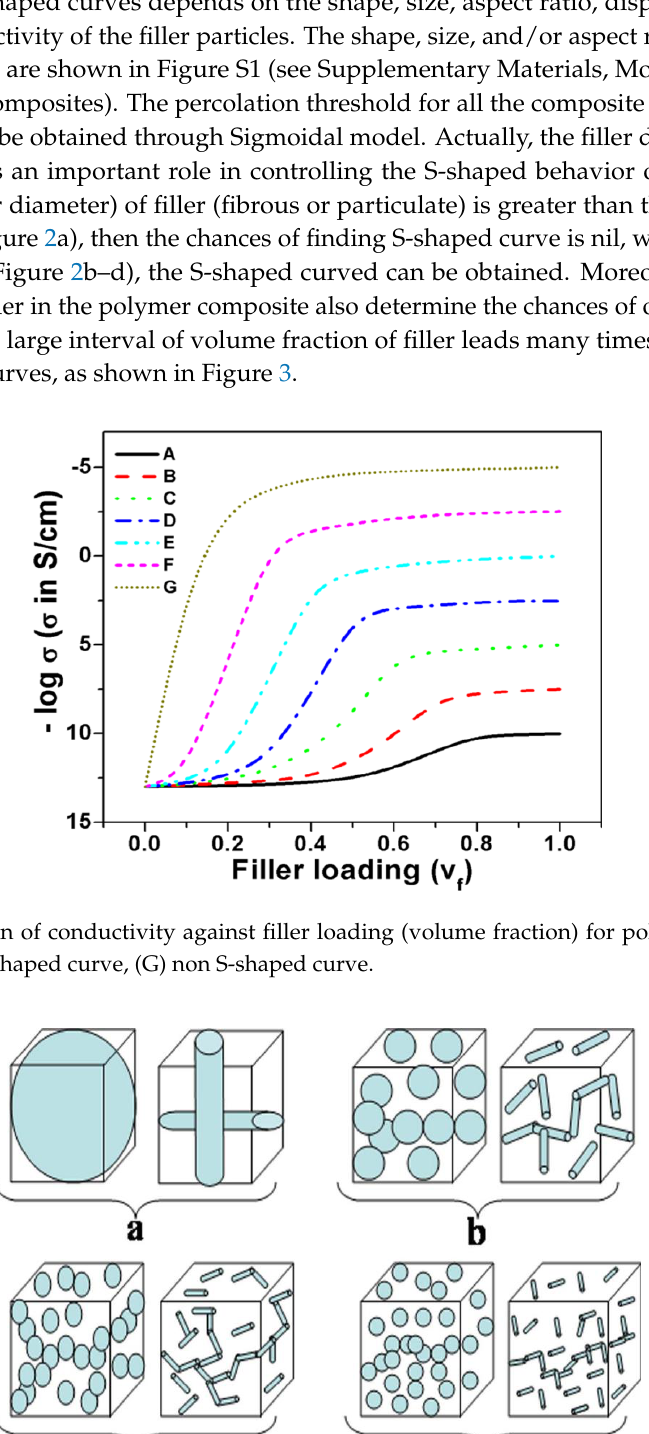
Figure 2. Dimension of particulate and fibrous fillers inside a polymer composite, dimension of filler in ( a ) is greater and ( b – d ) is smaller than the sample dimension.